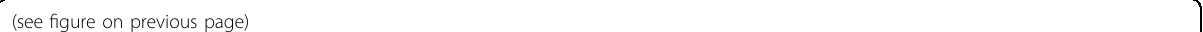
Fig. 7 Correlation among Prrx1 expression, stemness, angiogenesis, and TGF- β /smad pathway in xenograft model and glioma specimens. A U87-Luc cells stably transfected with sh-NC or sh-Prrx1 vectors were stereotactically implanted into mouse brains. Representative bioluminescent images of xenografts at day 0, day 10, and day 20 after tumor cell implantation were shown. B The fl uorescence signal intensity of xenografts in all groups. C Kaplan – Meier survival analysis of mice bearing xenografts. n = 6 for each group. D Paraf fi n-embedded xenograft sections were stained with antibody targeting human SOX2, Ki67, and CD31. E Prrx1 expression was positively correlated with SOX2, Ki67 expression, and microvascular density in 72 clinical glioma specimens. Scale bar represents 50 μ m. F Glioma specimens of GSE13041 dataset were divided into high expression group and low expression group based on the expression level of Prrx1 (top 1/3 and bottom 1/3). Expression heatmap of gene clusters associated with TGF- β /smad pathway, stemness, and angiogenesis in indicated groups was visualized. Z score normalized expression is graded by color. G Pearson correlation analysis was conducted to analyze the relation between Prrx1, TGF β 1, and SOX2 in multiple glioma GEO datasets. * P < 0.05, ** P < 0.01, *** P <